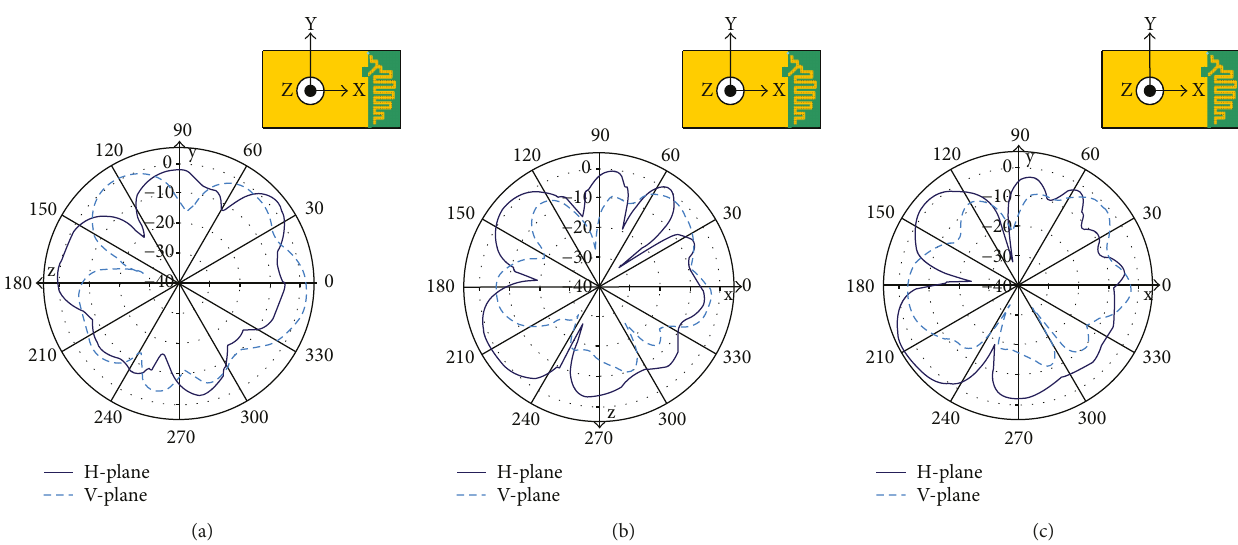
Figure 7: Measured radiation patterns in total fi elds (horizontal plane (H-Plane) and vertical plane (V-Plane)): (a) Y-Z plane, (b) X-Z plane, and (c) X-Y plane.